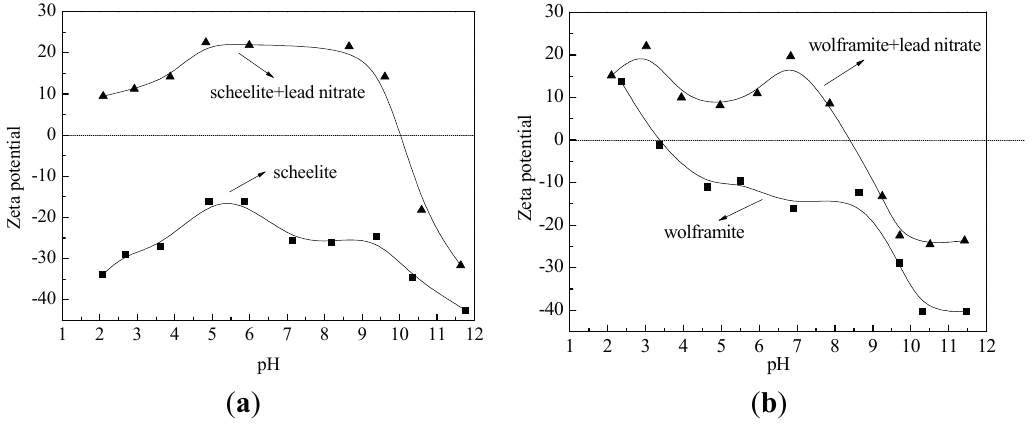
Figure 3. Zeta potential before and after the addition of lead nitrate: ( a ) scheelite; ( b )